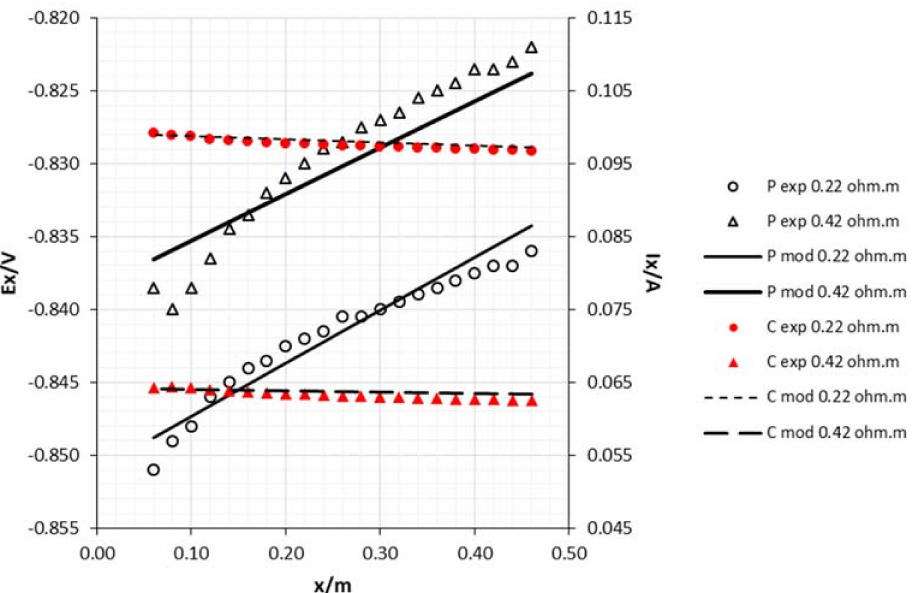
Figure 9. Experimental and model attenuation curves as a function of medium resistivity (sacrificial anode area: 0.0018 m 2 ; cathode diameter: 15 mm and edge draining point). Legend: P—potential; C—current; exp—experimental; mod—model.